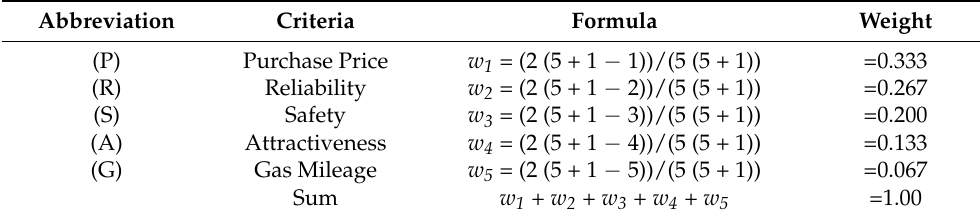
Table 14. Weight using RS